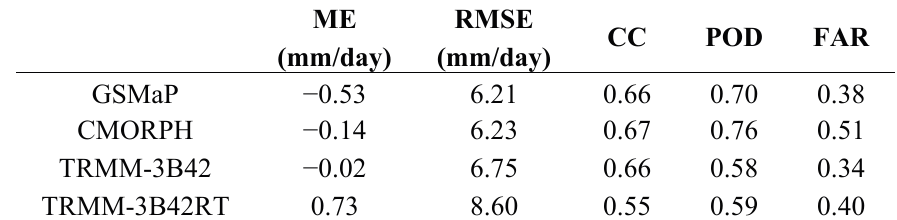
Table 3. Validation statistics of the four rainfall estimates over Mainland China from 2003 to 2006. ME RMSE CC POD FAR (mm/day) (mm/day) GSMaP −